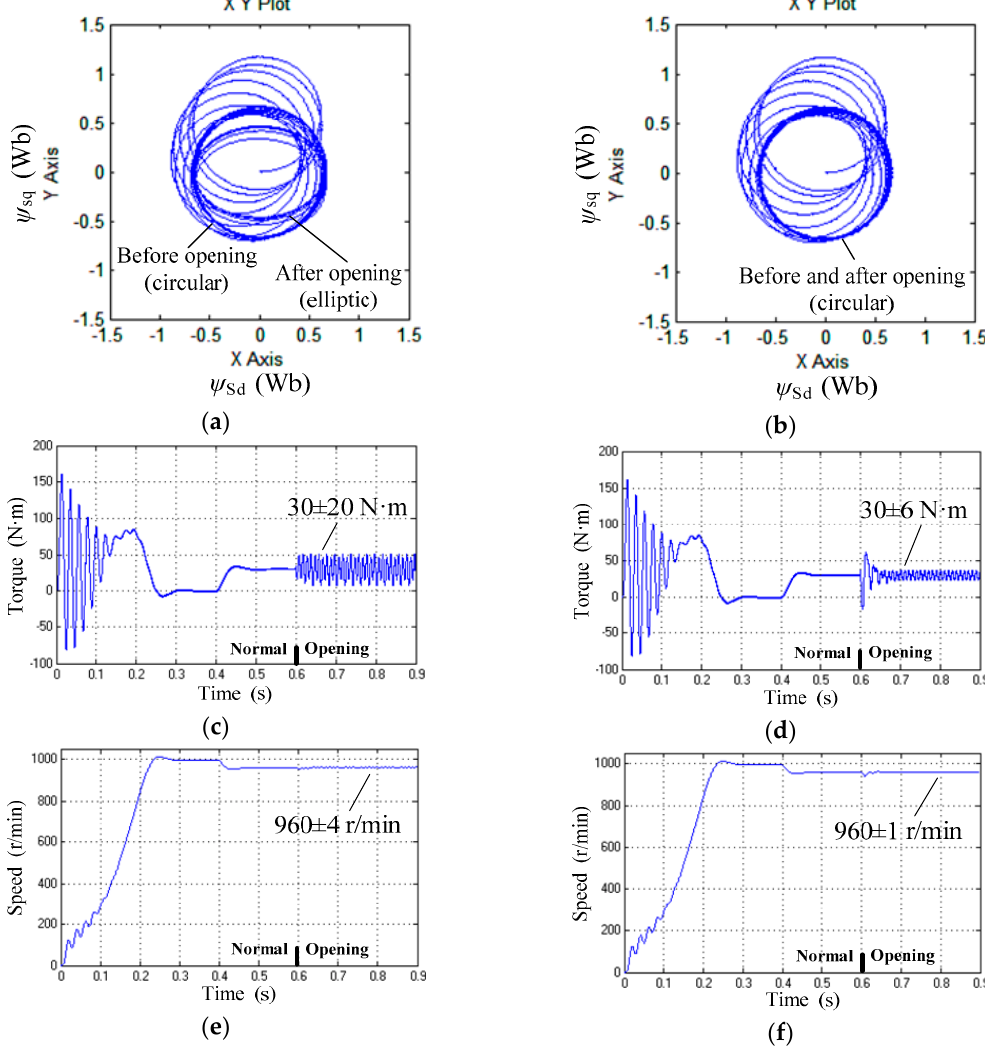
Figure 12. Fluxes, torques, and speeds in Simulations 1 and 2. ( a ) Stator flux trajectory in simulation 1; ( b ) Stator flux trajectory in simulation 2; ( c ) Electromagnetic torque in simulation 1; ( d ) Electromagnetic torque in simulation 2; ( e ) Rotor speed in simulation 1; ( f ) Rotor speed in simulation 2.